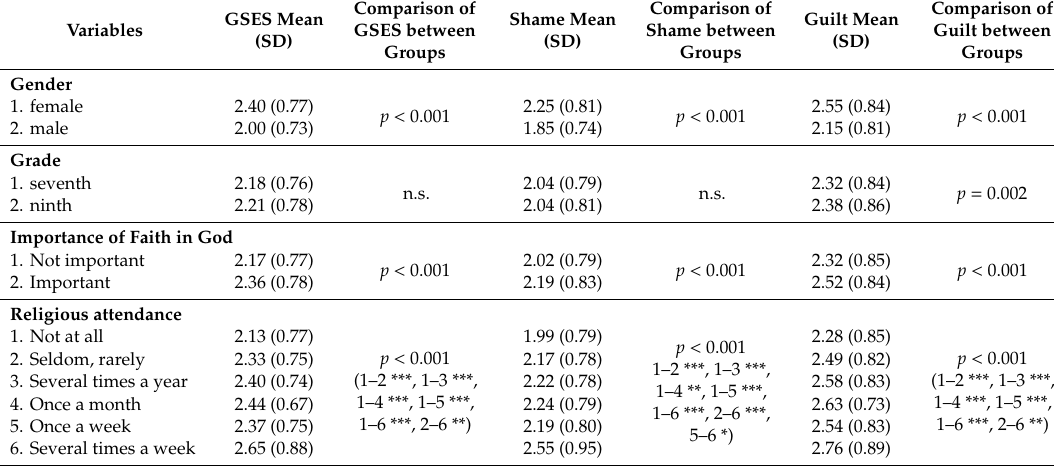
Table 1. Results of a nonparametric comparison of the mean scores of the Guilt and Shame Experience Scale (GSES) and its subscales in groups of adolescents (Wilcoxon rank-sum test and the Kruskal–Wallis test). The p -value refers to the comparison of all groups, whereas the relationships given in brackets are the result of multiple group comparisons. Comparison of Comparison of Comparison of Guilt Mean Shame Mean GSES Mean Guilt between Shame between GSES between (SD) (SD) (SD) Groups Groups